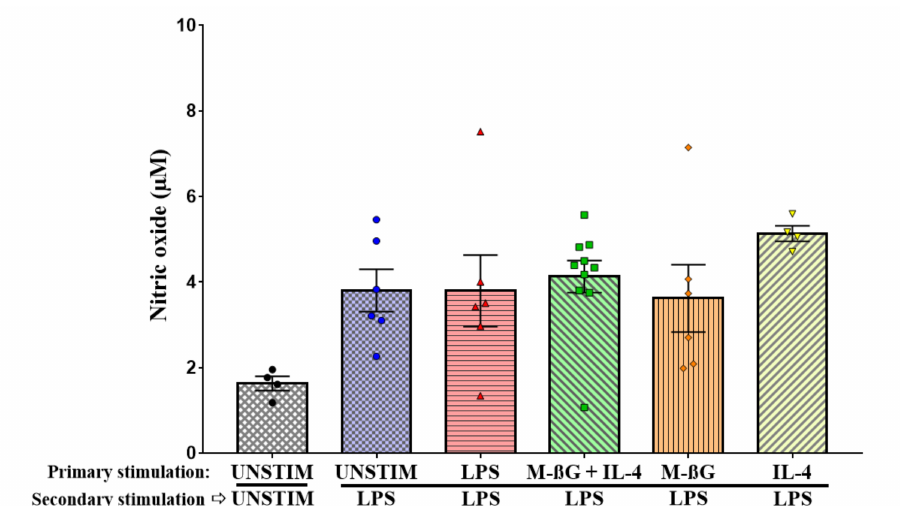
Figure A3. Bone marrow-derived adherent cells primary stimulated with M- β G + IL-4 failed to enhance NO production after secondary stimulation of LPS. Freshly isolated chicken bone marrow-derived adherent cells were primary stimulated with culture medium (UNSTIM), LPS (10 µ g / mL), M- β G (10 µ g / mL), M- β G + IL-4 (10 µ g / mL + 100 ng / mL) or IL-4 (100 ng / mL), on D0. The cells were secondary stimulated with LPS (10 µ g / mL) except the negative control (UNSTIM-UNSTIM) on D6. Results after this LPS stimulation are shown in this figure. LPS induced NO production for all treatment groups. In contrast to blood-derived macrophages, a secondary stimulation with LPS did not a ff ect the NO production in M- β G + IL-4 primary stimulated cells compared to the primary unstimulated cells (UNSTIM-LPS). ( N = 6–10 chickens; N for UNSTIM-UNSTIM and IL-4 = 4 chickens). Each bar represents mean ±